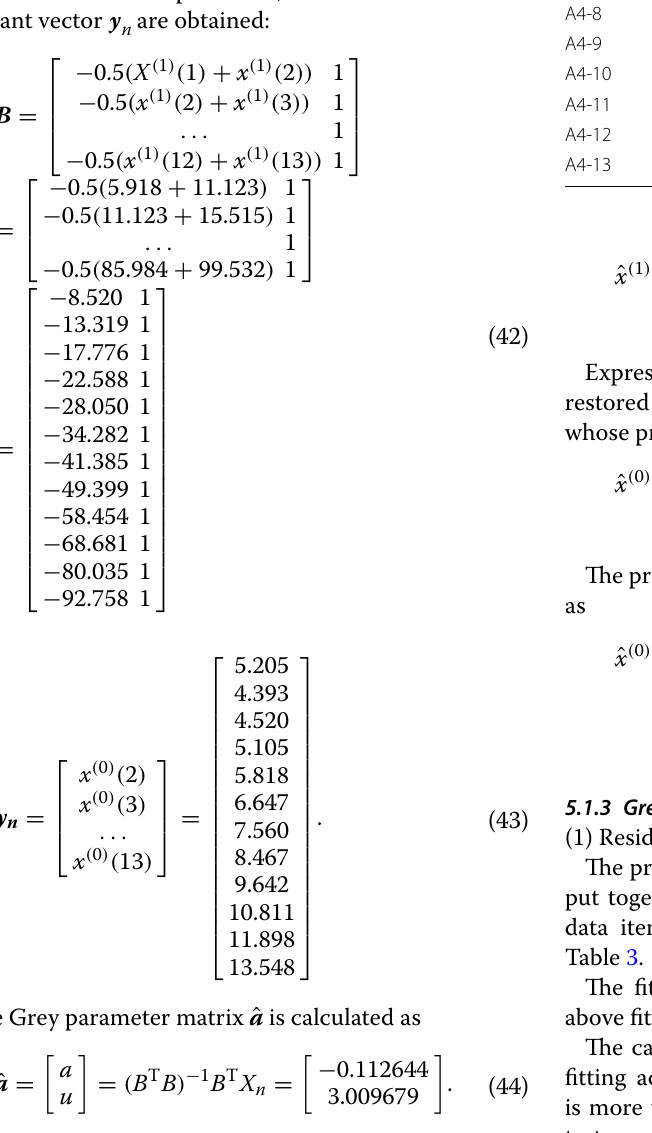
The fitting curve of centroid offsets drawn from